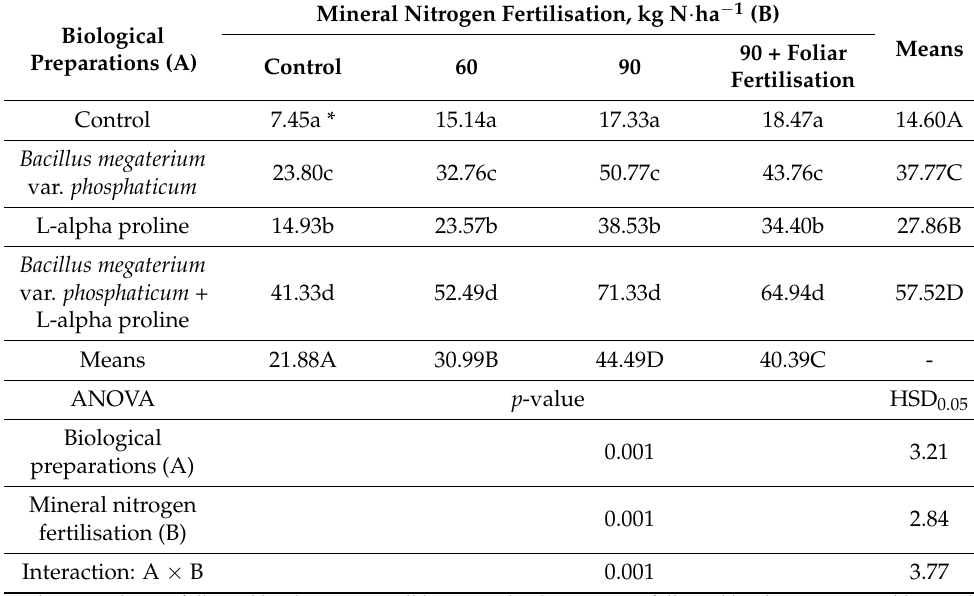
Table 6. Fe uptake by spring wheat grain (means across 2017–2019), g · ha − 1